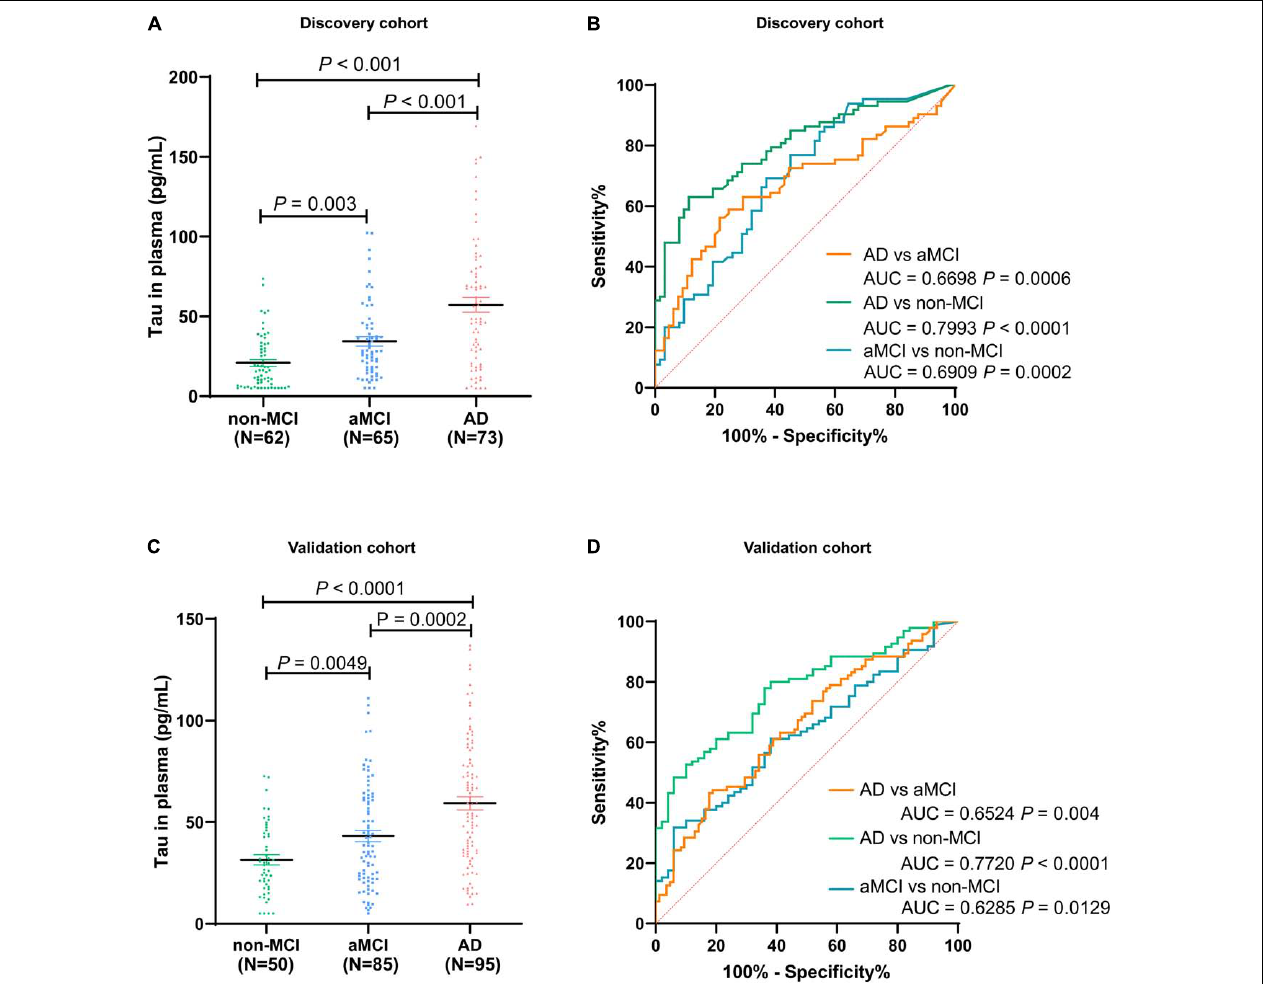
FIGURE 4 | Distribution of total Tau in plasma among non-MCI, aMCI, and AD populations in discovery cohort (A) and validation cohort (C) . The ROC analyses of total Tau in AD patients, aMCI patients, and non-MCI participants in the discovery cohort (B) and validation cohort (D) . In the discovery cohort, n = 73 (AD), 65 (aMCI), and 62 (non-MCI). In the validation cohort, n = 95 (AD), 85 (aMCI), and 50